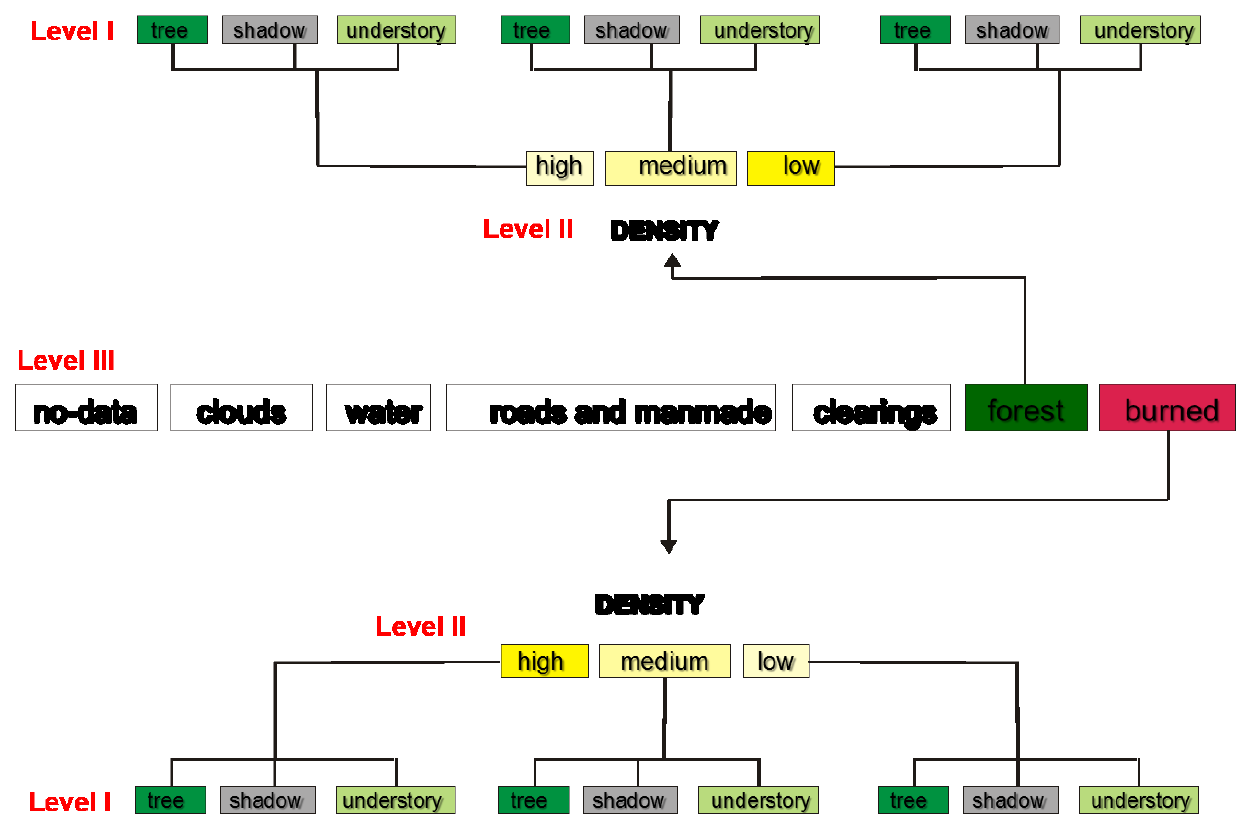
Figure 5. Three level hierarchical classification